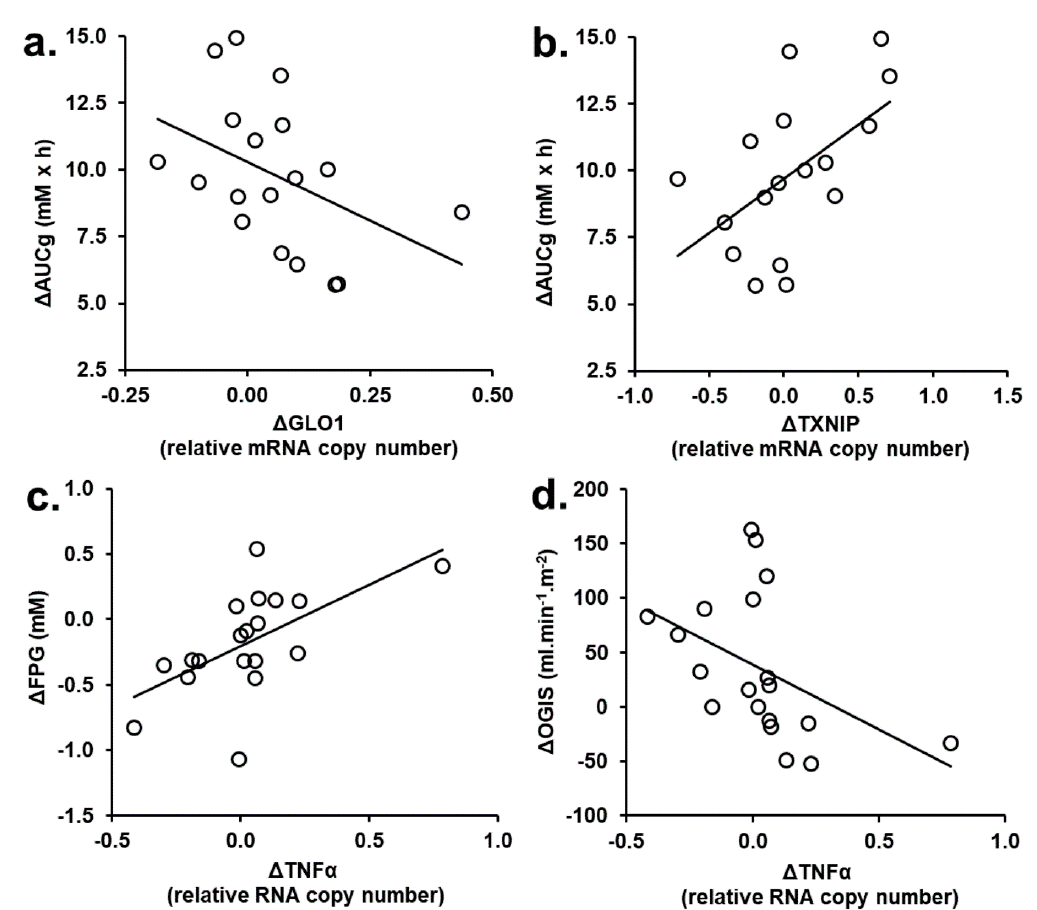
Figure 2. Correlation of variables of metabolic health with change in PBMC gene expression in highly overweight and obese subjects of the HATFF study during treatment with tRES-HESP. ( a ) Change of AUCg ( ∆ AUCg) on change expression of Glo1 ( ∆ GLO1); r = − 0.56, p < 0.05. Regression equation: ∆ AUCg = ( − 8.8 × ∆ GLO1) + 10.3. ( b ) Change of AUCg ( ∆ AUCg) on change in expression of TXNIP ( ∆ TXNIP); r = 0.59, p < 0.05. Regression equation: ∆ AUCg = (4.1 × ∆ TXNIP) + 9.7. ( c ) Change in FPG ( ∆ FPG) on change in expression of TNF α ( ∆ TNF α ); r = 0.70, p < 0.001. Regression equation: ∆ FPG = (0.94 × ∆ TNF α ) − 0.20. ( d ) Change in OGIS ( ∆ OGIS) on ∆ TNF α ; r = − 0.68, p < 0.01. Regression equation: ∆ OGIS = ( − 119 × ∆ TNF α ) + 39. n =